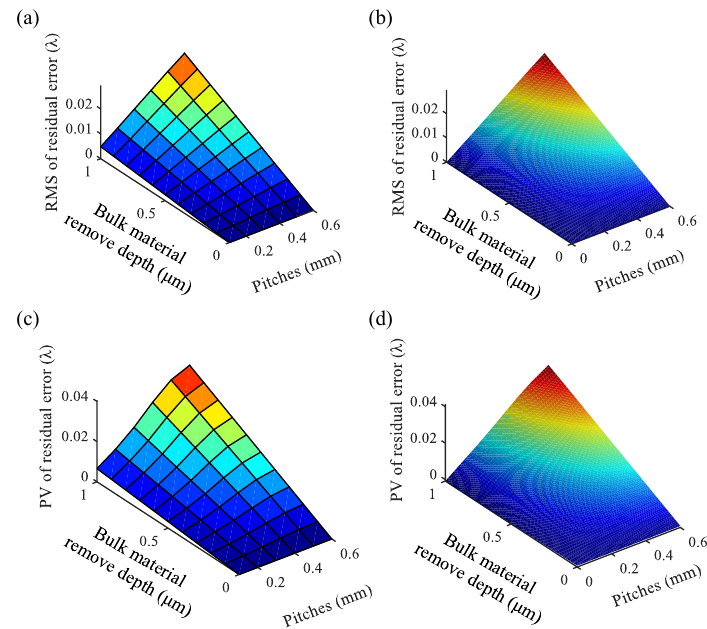
Figure 5. ( a ) Original RMS map; ( b ) fitted map of RMS; ( c ) original PV map; ( d ) fitted map of